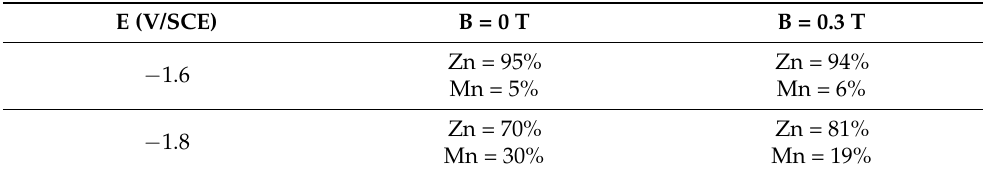
Table 1. Chemical composition of Zn–Mn alloy coatings (at (%)) obtained by EDS for two imposed potentials E = − 1.6 V/SCE and E = − 1.8 V/SCE and for two magnetic field amplitudes B = 0 T and B = 0.3 T. The standard error is around 1 at % for all